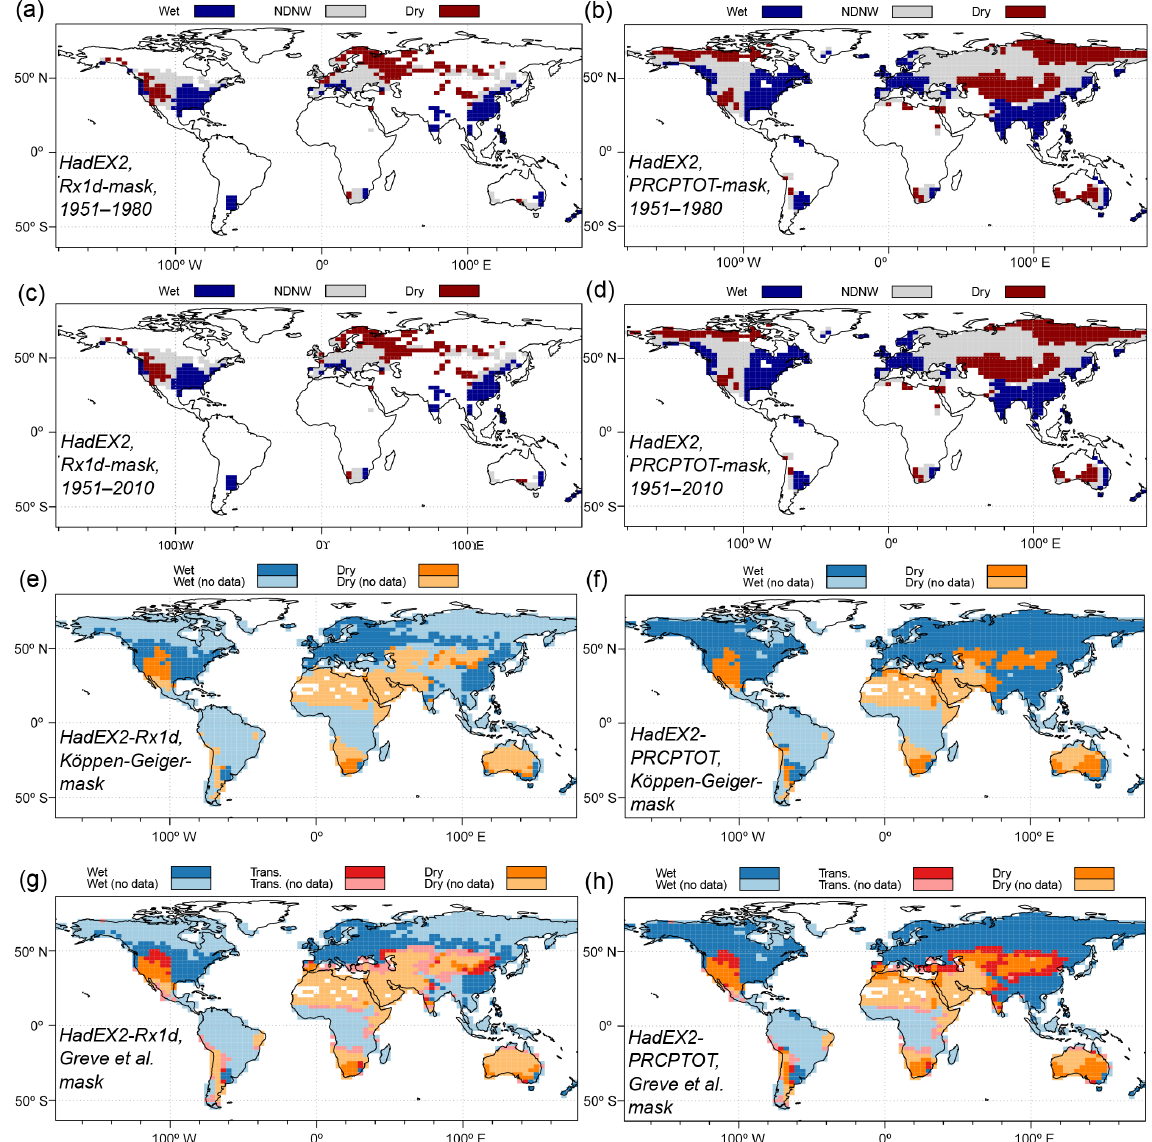
Figure 3. Different mask of the world’s dry and wet regions. (a) – (d) Dryness/wetness masks based on 1951–1980 and HadEX2 ( a, b ; see Donat et al., 2016) and 1951–2010 ( c, d ; to avoid “regression to the mean” selection bias, see main text) for Rx1d (left panels) and PRCPTOT (right panels). “NDNW” indicates neither dry nor wet areas, white inland areas indicate less than 90% data availability in the HadEX2 dataset and were not considered. (e, f) Dry regions based on the Köppen–Geiger classification as updated by Kottek et al. (2006) and data availability in HadEX2. (g, h) Dry and transitional regions following Greve et al. (2014) and data availability in